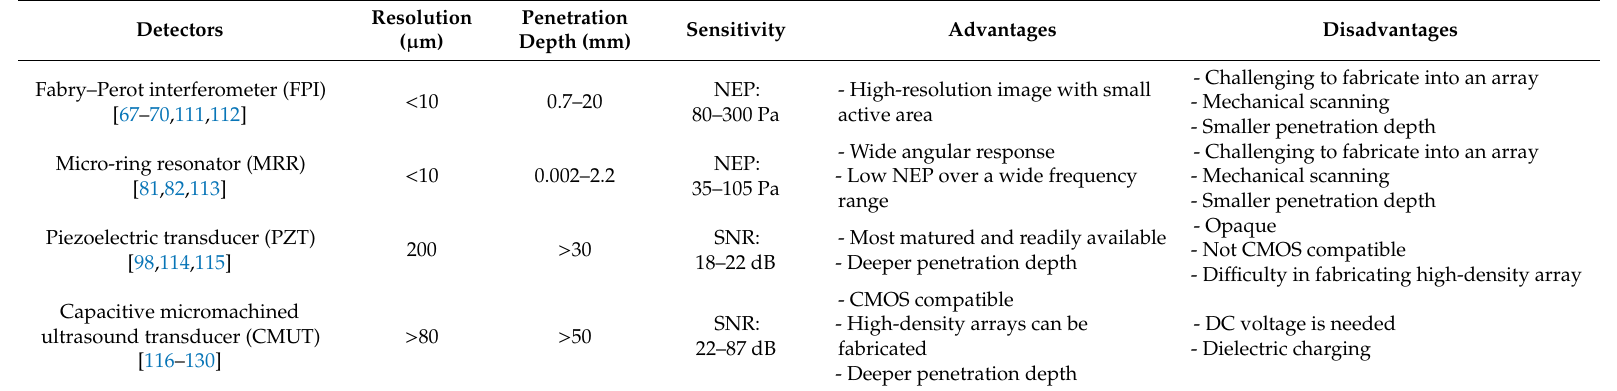
Table 2. The performance of di ff erent acoustic detectors along with their advantages and disadvantages in PAI